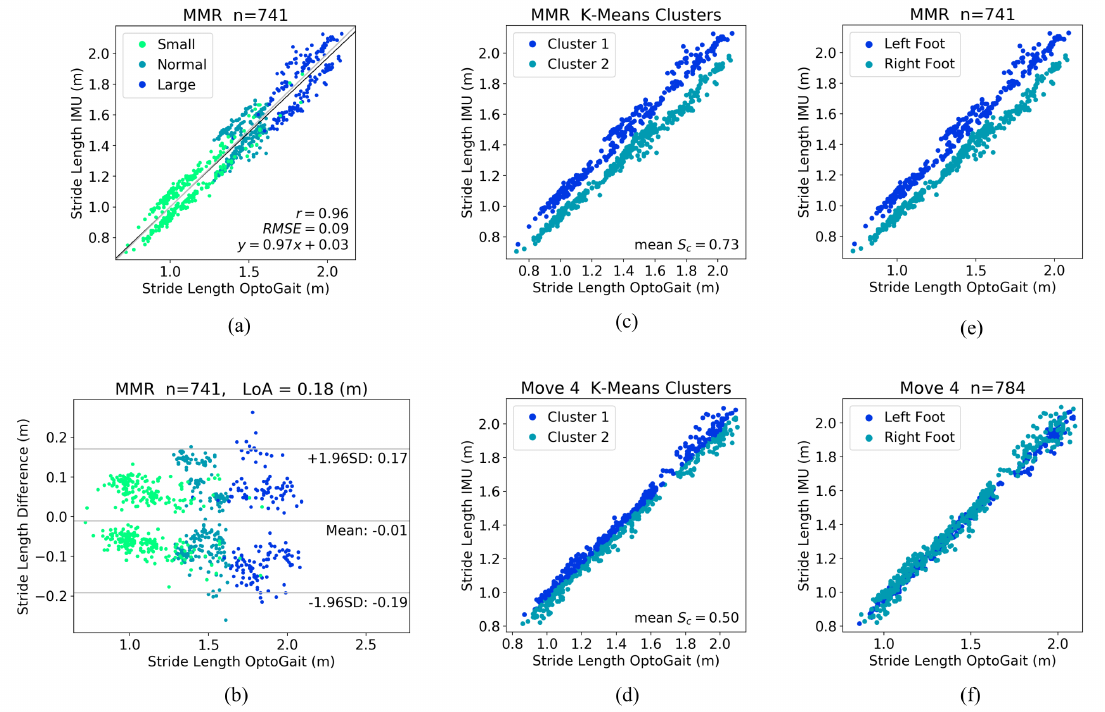
Figure 9. Evaluation of stride lengths from left and right foot derived from MMR IMU data, and reference data from Move 4 IMUs. ( a ) and ( b ) correlation analysis and Bland-Altman plot of stride length derived from MMR data, ( c ) and ( d ) K-Means clustering based on the stride length differences between IMU and OptoGait measurements, ( e ) and ( f ) correlation analysis of stride length grouped by left and right foot, for MMR and Move 4 IMUs, respectively. S c : silhouette